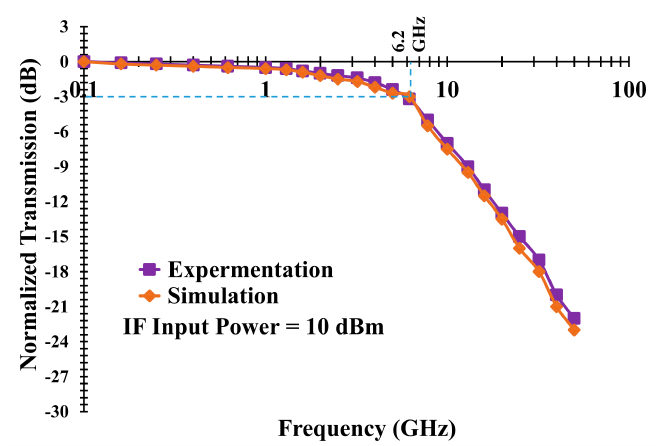
Figure 4. MZM dynamic characteristic for simulation and experimental